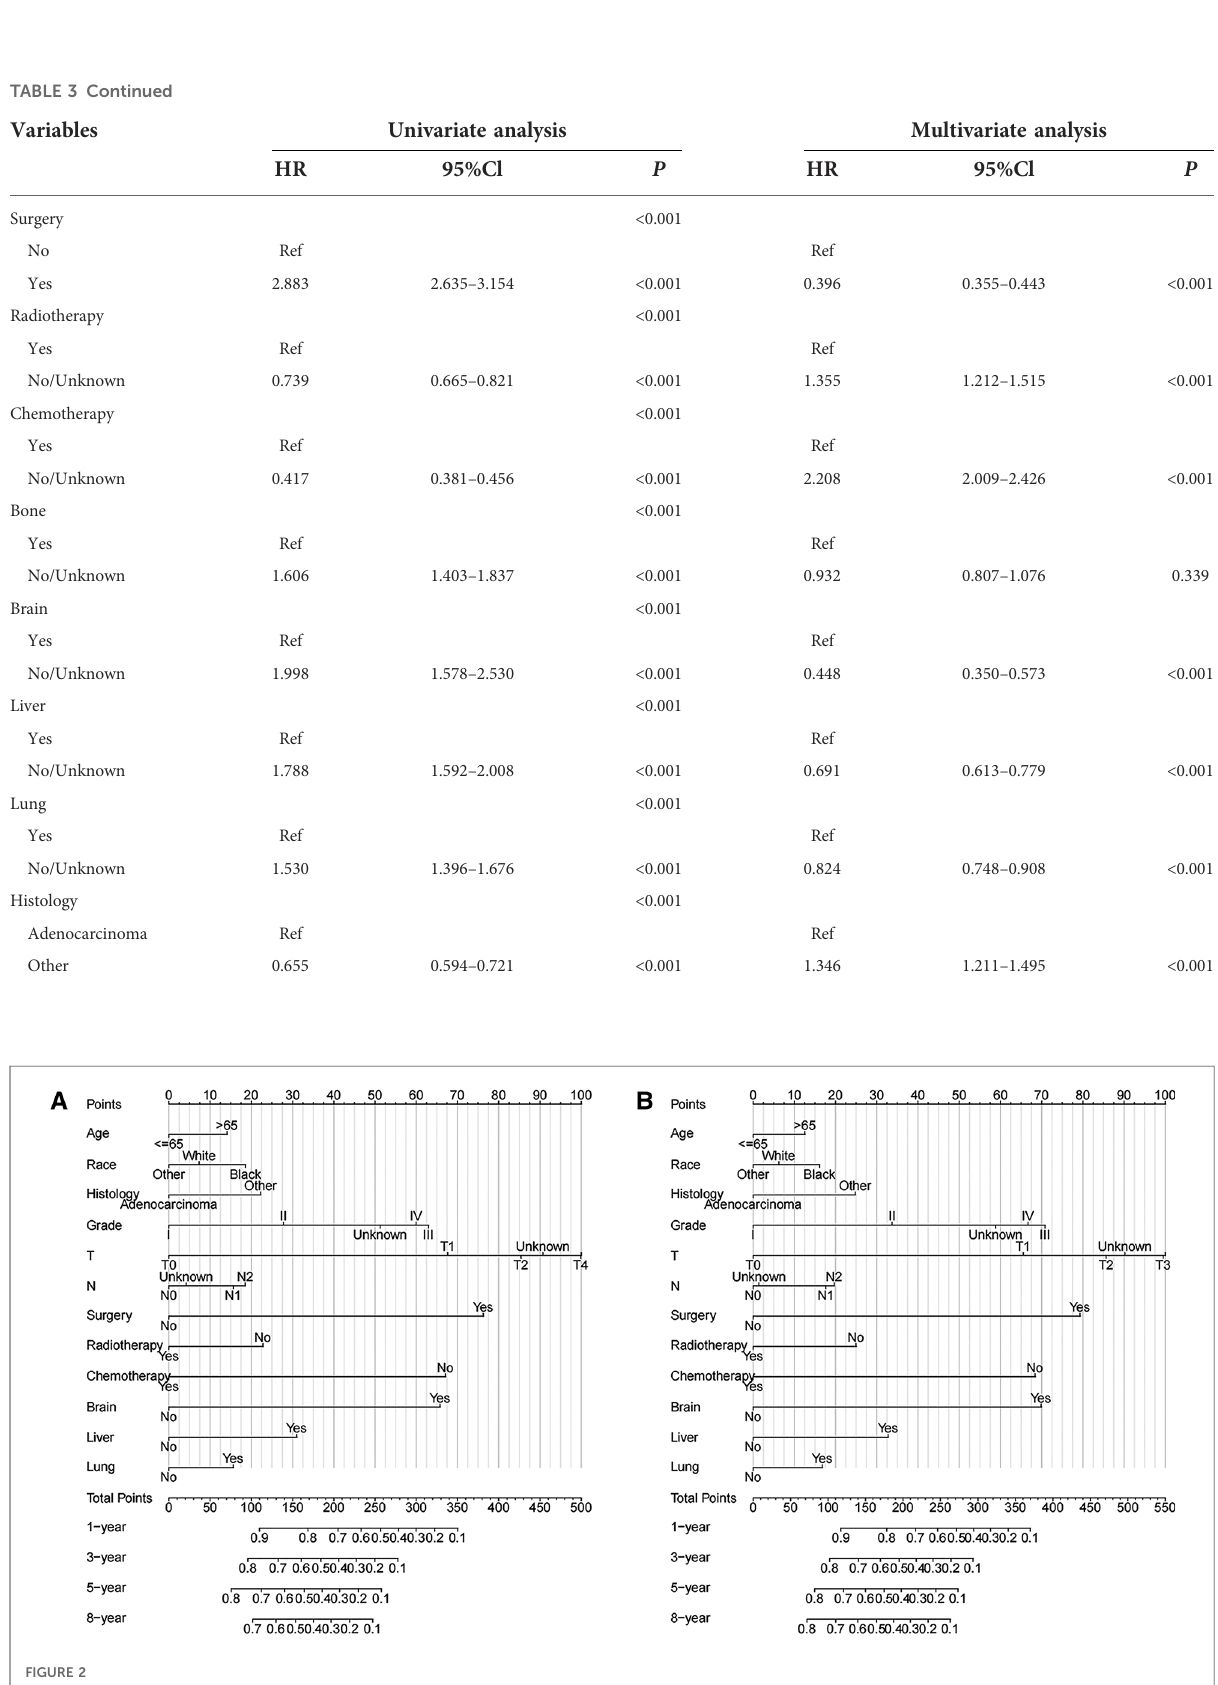
FIGURE 2 Nomograms of metastatic endometrial cancer to predict 1-,3-,5- and 8-year survival rates ( A ) OS and ( B )